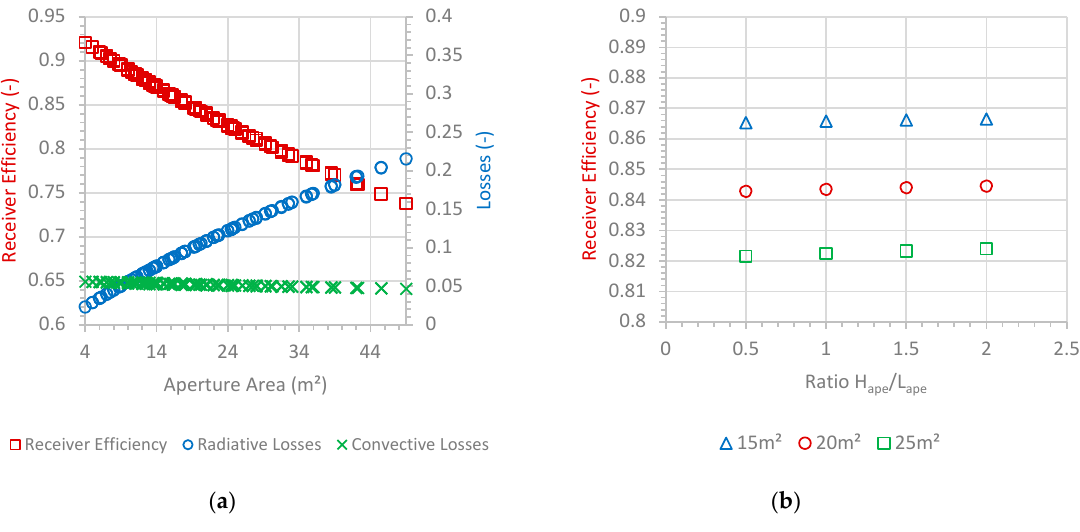
Figure 9. ( a ) Influence of the aperture area on the different losses—normalized by the receiver power—and efficiency, and ( b ) Influence of the aperture shape on the receiver efficiency, for the same parameters as previously.